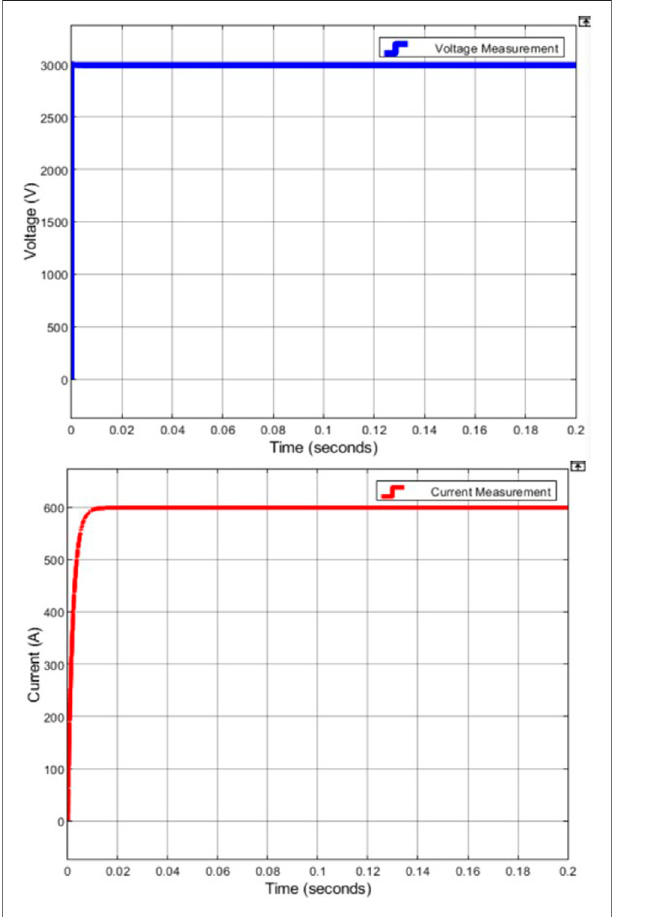
FIGURE 15 | Simulated voltage and current